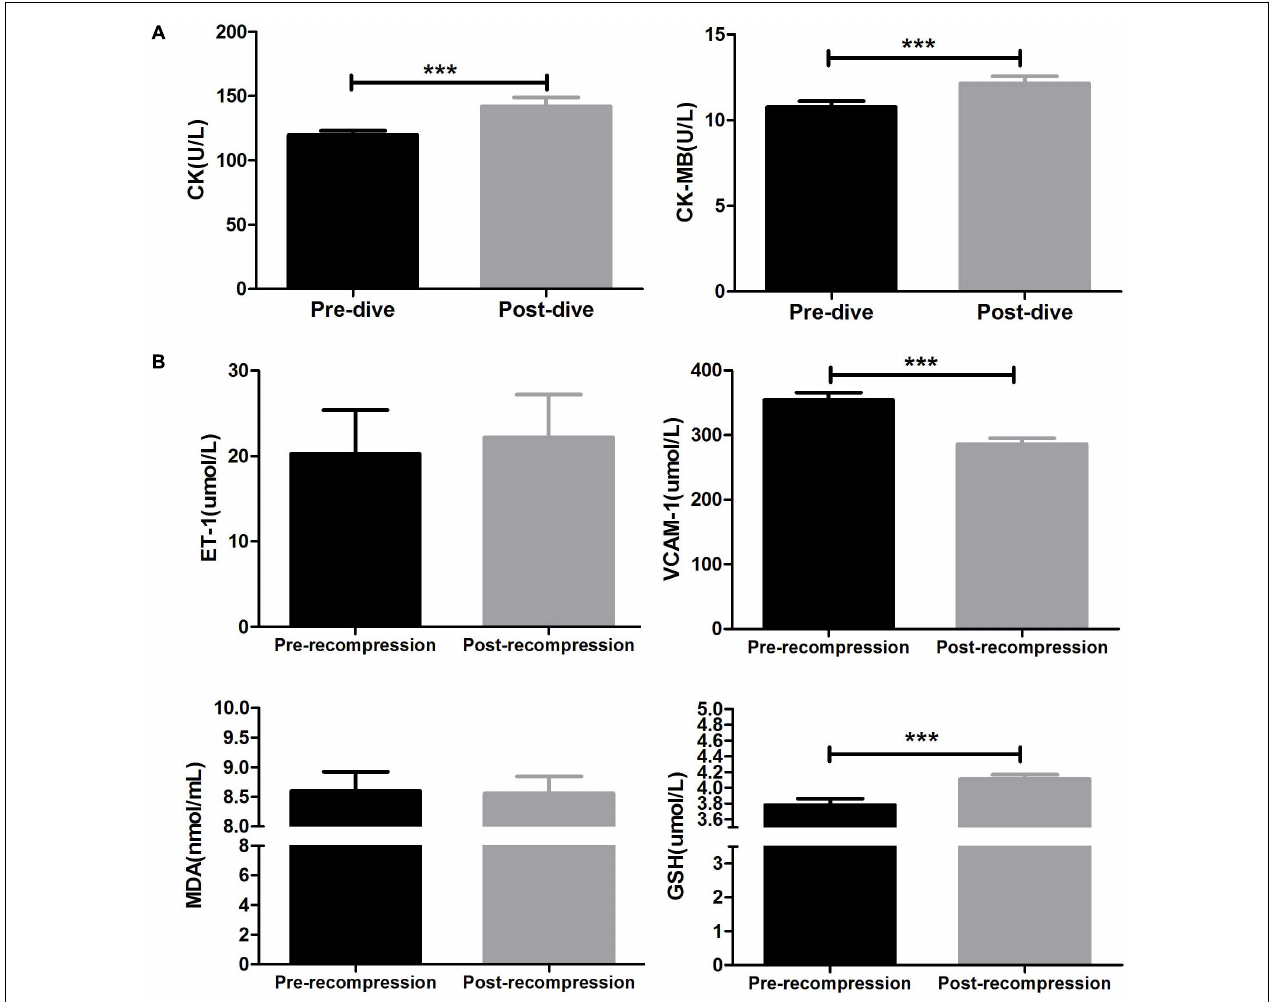
FIGURE 3 | Changes in myocardial enzymes and serum indices before and after 80 m heliox diving. (A) Creatine kinase (CK) and myocardial-specific isoenzyme of creatine kinase (CK-MB) decreased significantly after ascent to the surface. *** P < 0.0001 compared with the predive group. The CK and CK-MB data met the homogeneity of variance and were analyzed using a paired t -test. (B) Changes in endothelin-1 (ET-1), vascular cell adhesion molecule-1 (VCAM-1), serum glutathione (GSH), and malondialdehyde (MDA) concentrations between before and after recompression treatment in a hyperbaric oxygen chamber. *** P < 0.0001 compared with pretreatment. Data are means ± SD ( n = 40). The ET-1, VCAM-1, GSH, and MDA data did not meet the homogeneity of variance and were analyzed using an unpaired t -test with Welch’s correction.